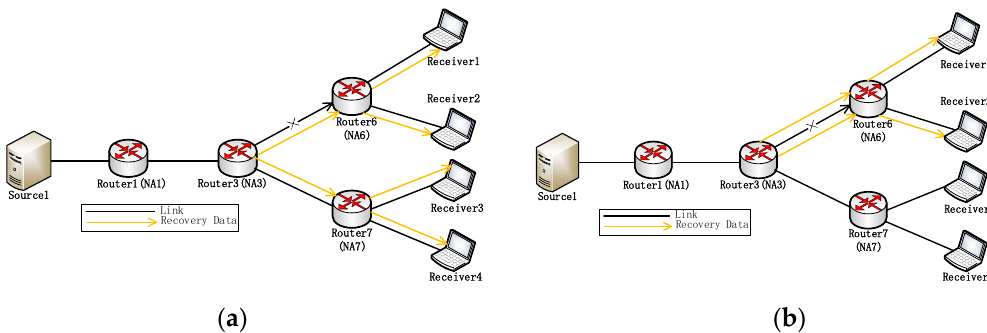
Figure 4. Comparison of different reliable multicast retransmission methods: ( a ) multicast-based retransmission method; ( b ) unicast-based retransmission method.